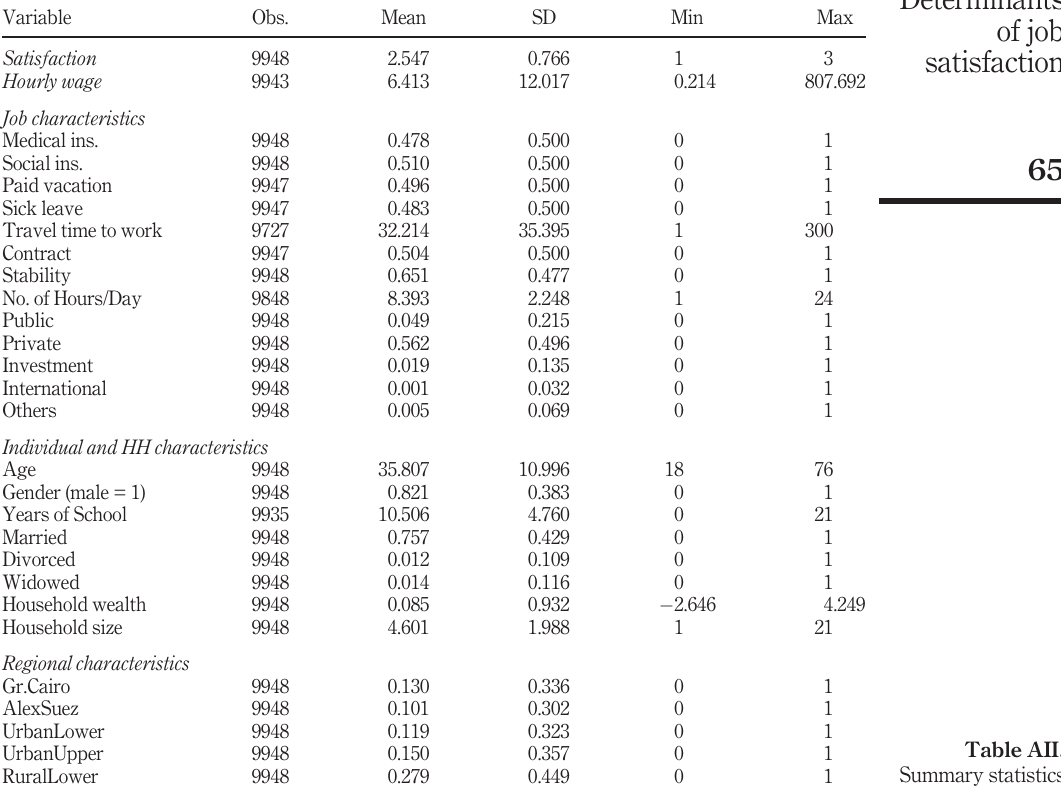
Table AII. Summary